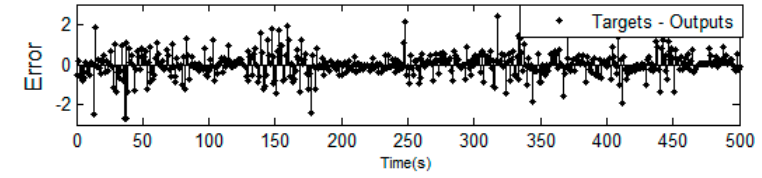
Figure 10. Error of single-step prediction.